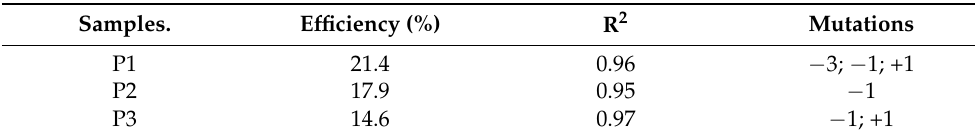
Table 1. Genotyping of targeted gene mutations induced by CRISPR/Cas9 RNPs in the three transformed protoplast samples: editing efficiency, goodness-of-fit measure (R 2 ), and mutations are